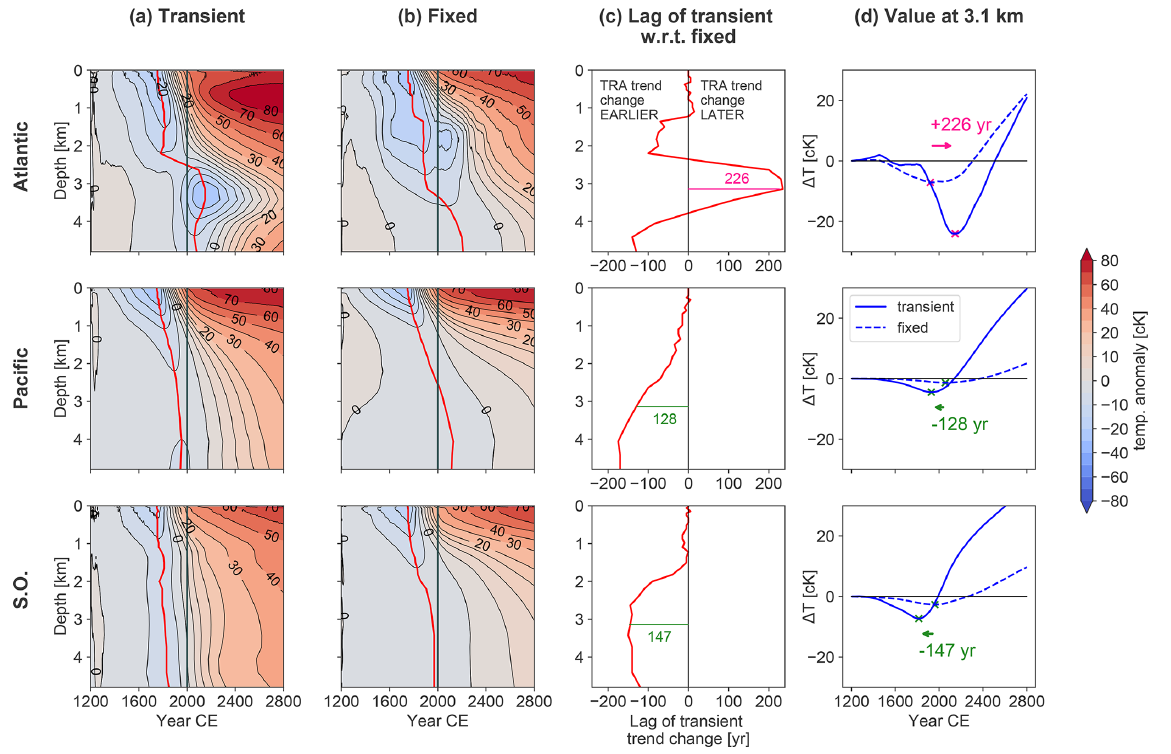
Figure 4. (a, b) Hovmöller diagrams of temperature anomalies in centi-Kelvin (1cK = 10 − 2 K) over depth. Values are basin averages of the Atlantic or Pacific (35 ◦ S–70 ◦ N) or the Southern Ocean ( < 35 ◦ S). Colour levels increase in steps of 5cK from − 20 to 20cK and in steps of 10cK otherwise. Red lines track the minimum temperature anomaly and indicate where the temperature trend changes from cooling to warming. (c) The lag in occurrence of the transient minimum temperature anomaly with respect to the fixed anomaly. This equals the red line in (a) minus the red line in (b) . (d) Temperature anomalies from (a, b) are repeated for a fixed 3.1km depth. Pink and green arrows indicate lags (positive) and leads (negative) of the transient with respect to fixed simulation in the temperature trend change at this depth (also indicated in c ). Results are for simulations OcTRA (transient) and OcFIX